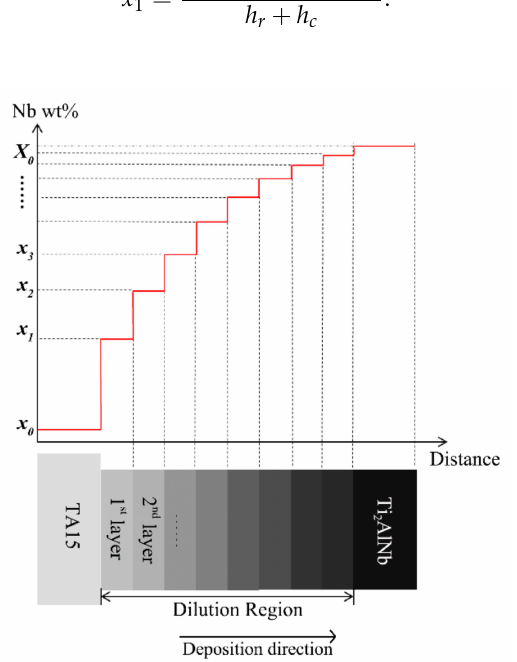
Figure 8. The schematic of the forming mechanism of the dilute region in the LSF TA15 / Ti 2 AlNb 10-layer deposited